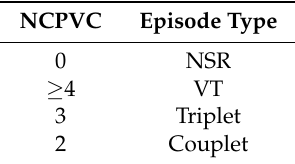
Table 3. Relationship between number of consecutive PVCs (NCPVC) and the type of